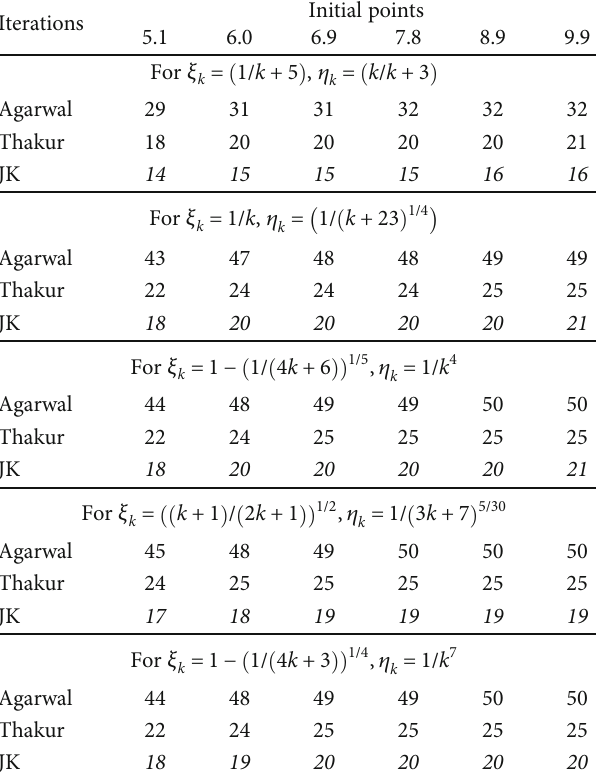
Table 2: In fl uence of parameters: comparison of various iterative schemes.